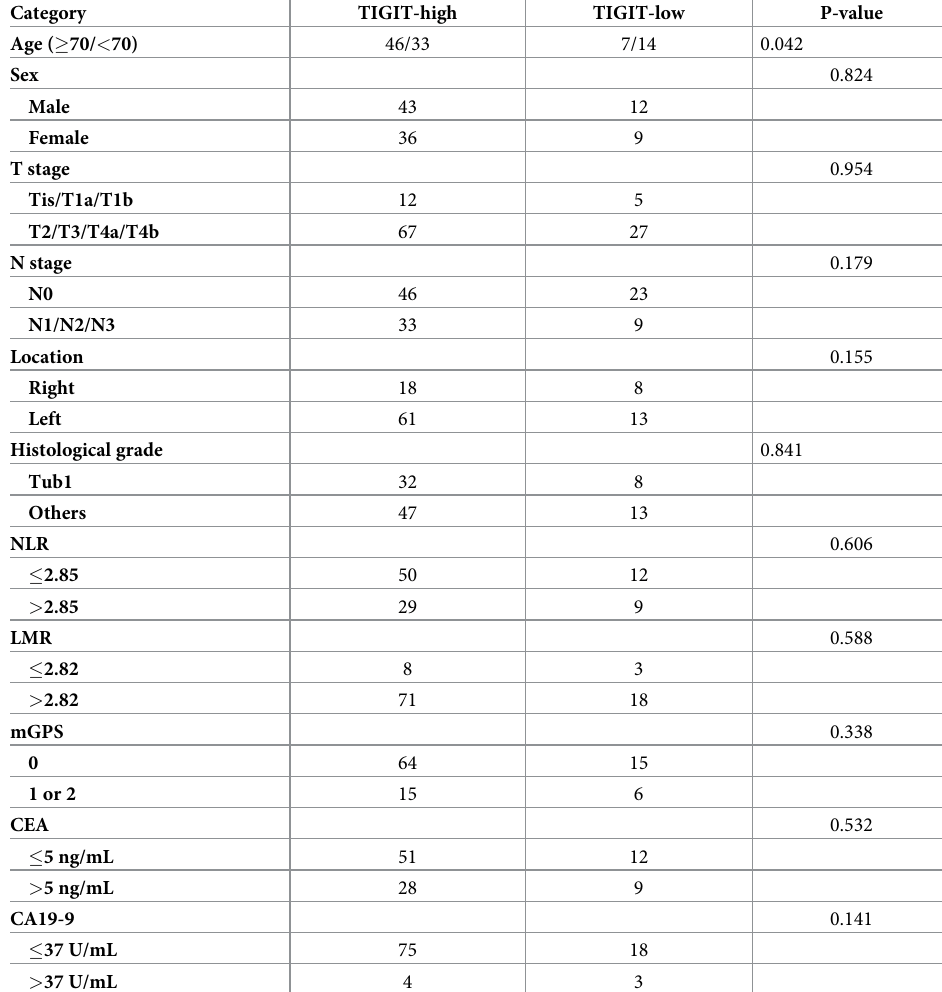
Table 2. Patient background and TGIT expression